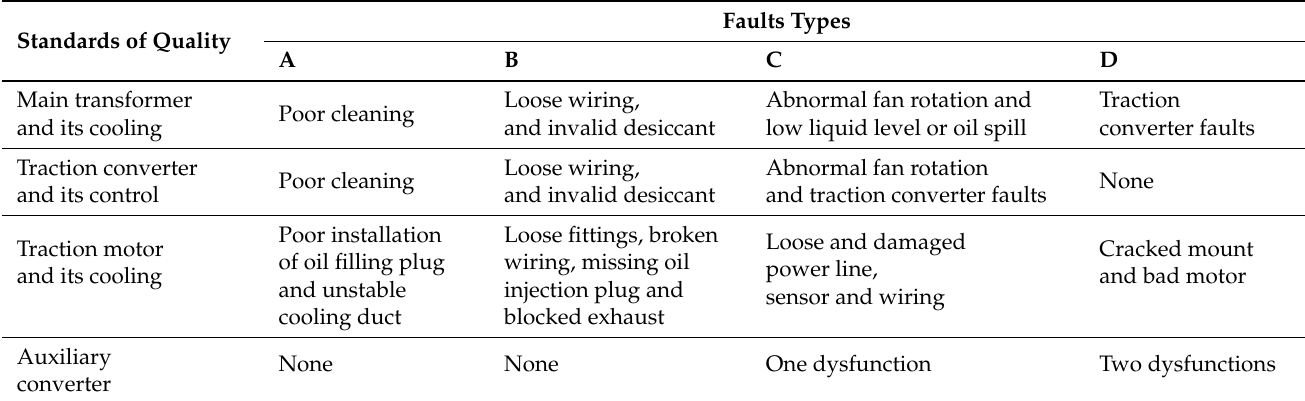
Table 2. Evaluation standards of electrical drive